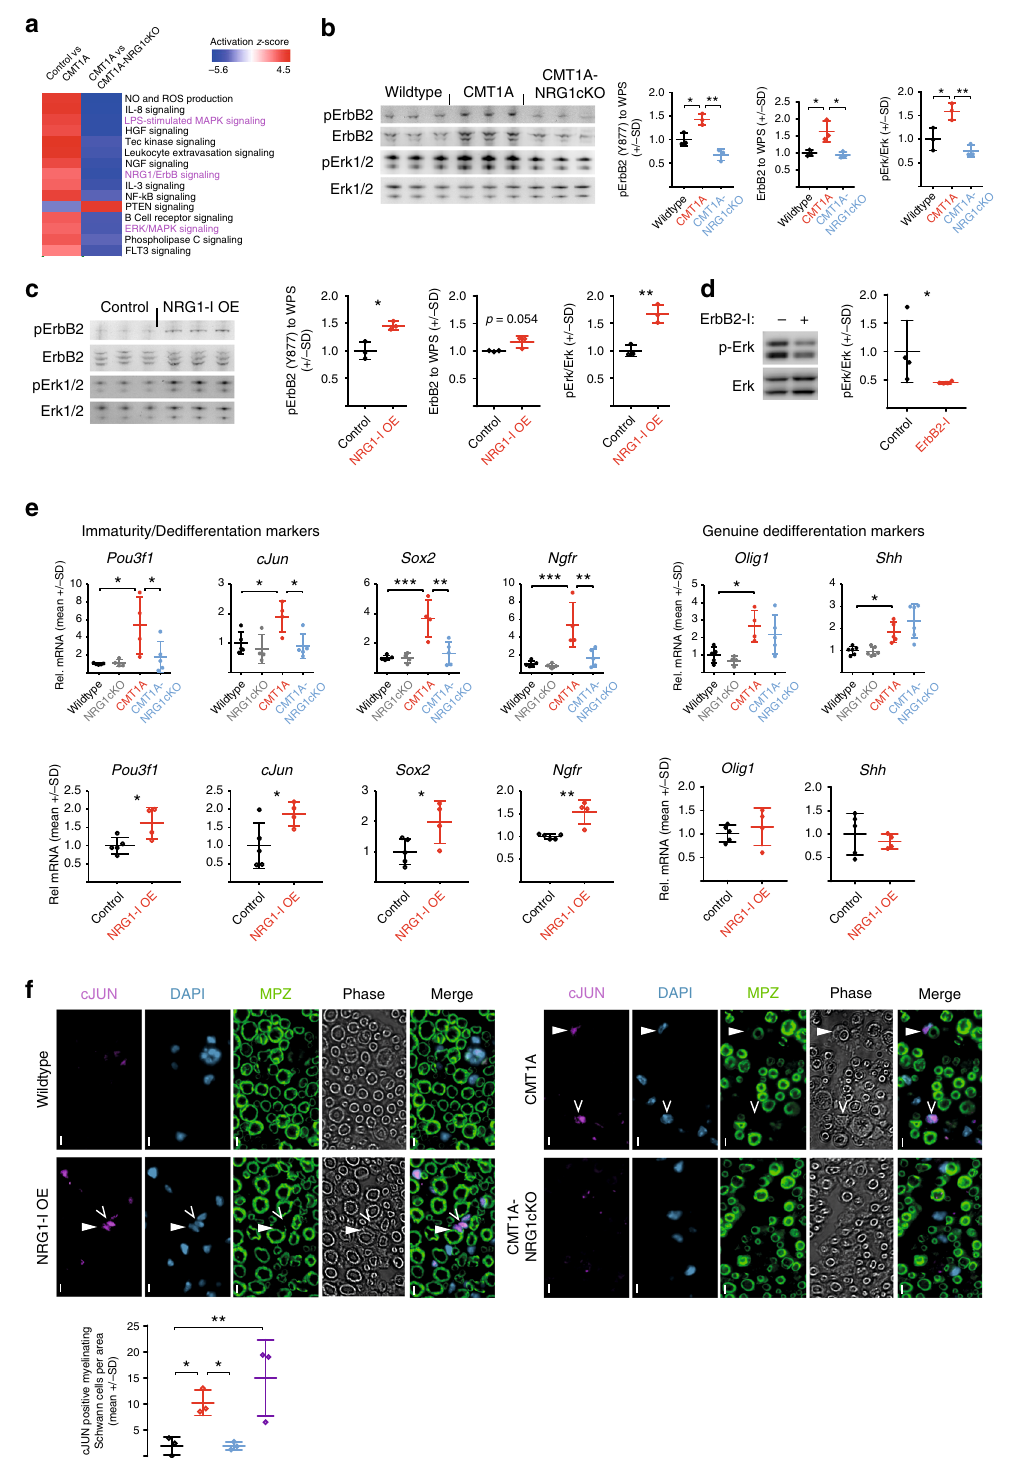
for a null mutation in the same gene ( Mpz ) upregulate Nrg1-I mRNA at earlier disease stages, in accordance with an early-onset severe hypomyelination (Fig. 1a). Together, these data suggest variable timing of distinct disease-associated processes that act upstream of NRG1-I induction.